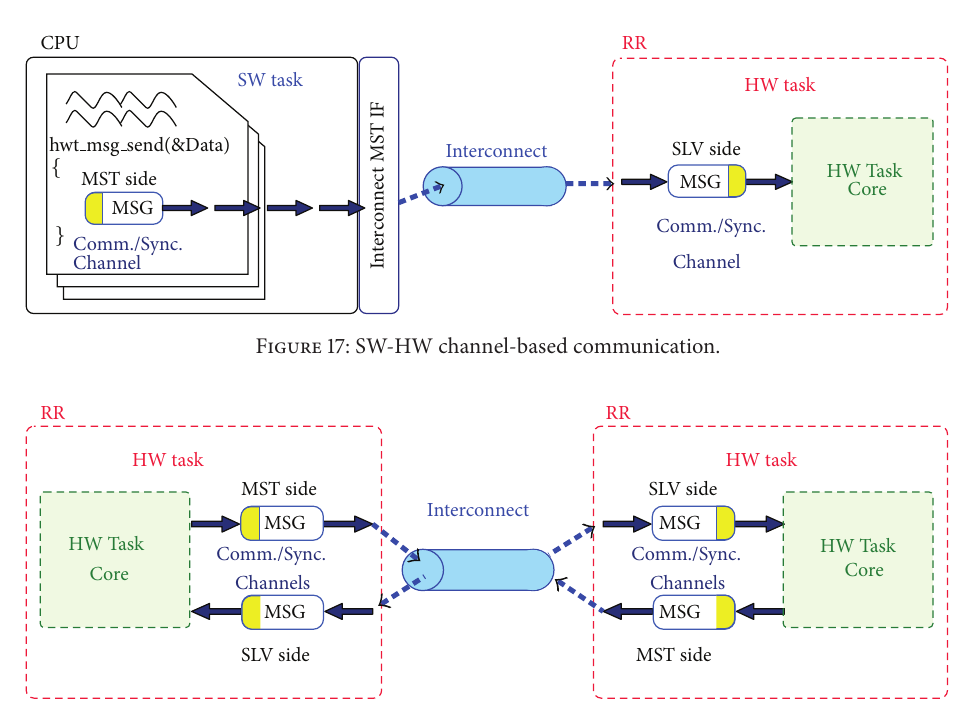
Figure 18: HW-HW channel-based